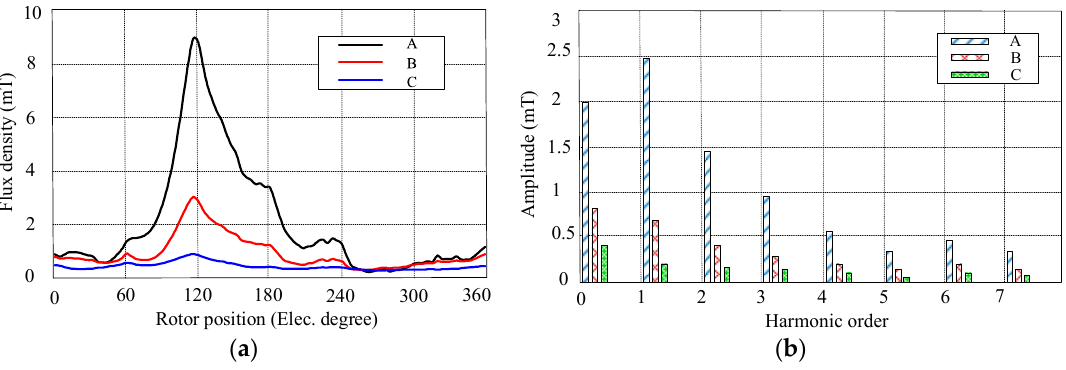
Figure 6. Magnetic flux density of point A, B, and C without field-excitation current: ( a ) magnetic flux density and ( b ) harmonic analysis.